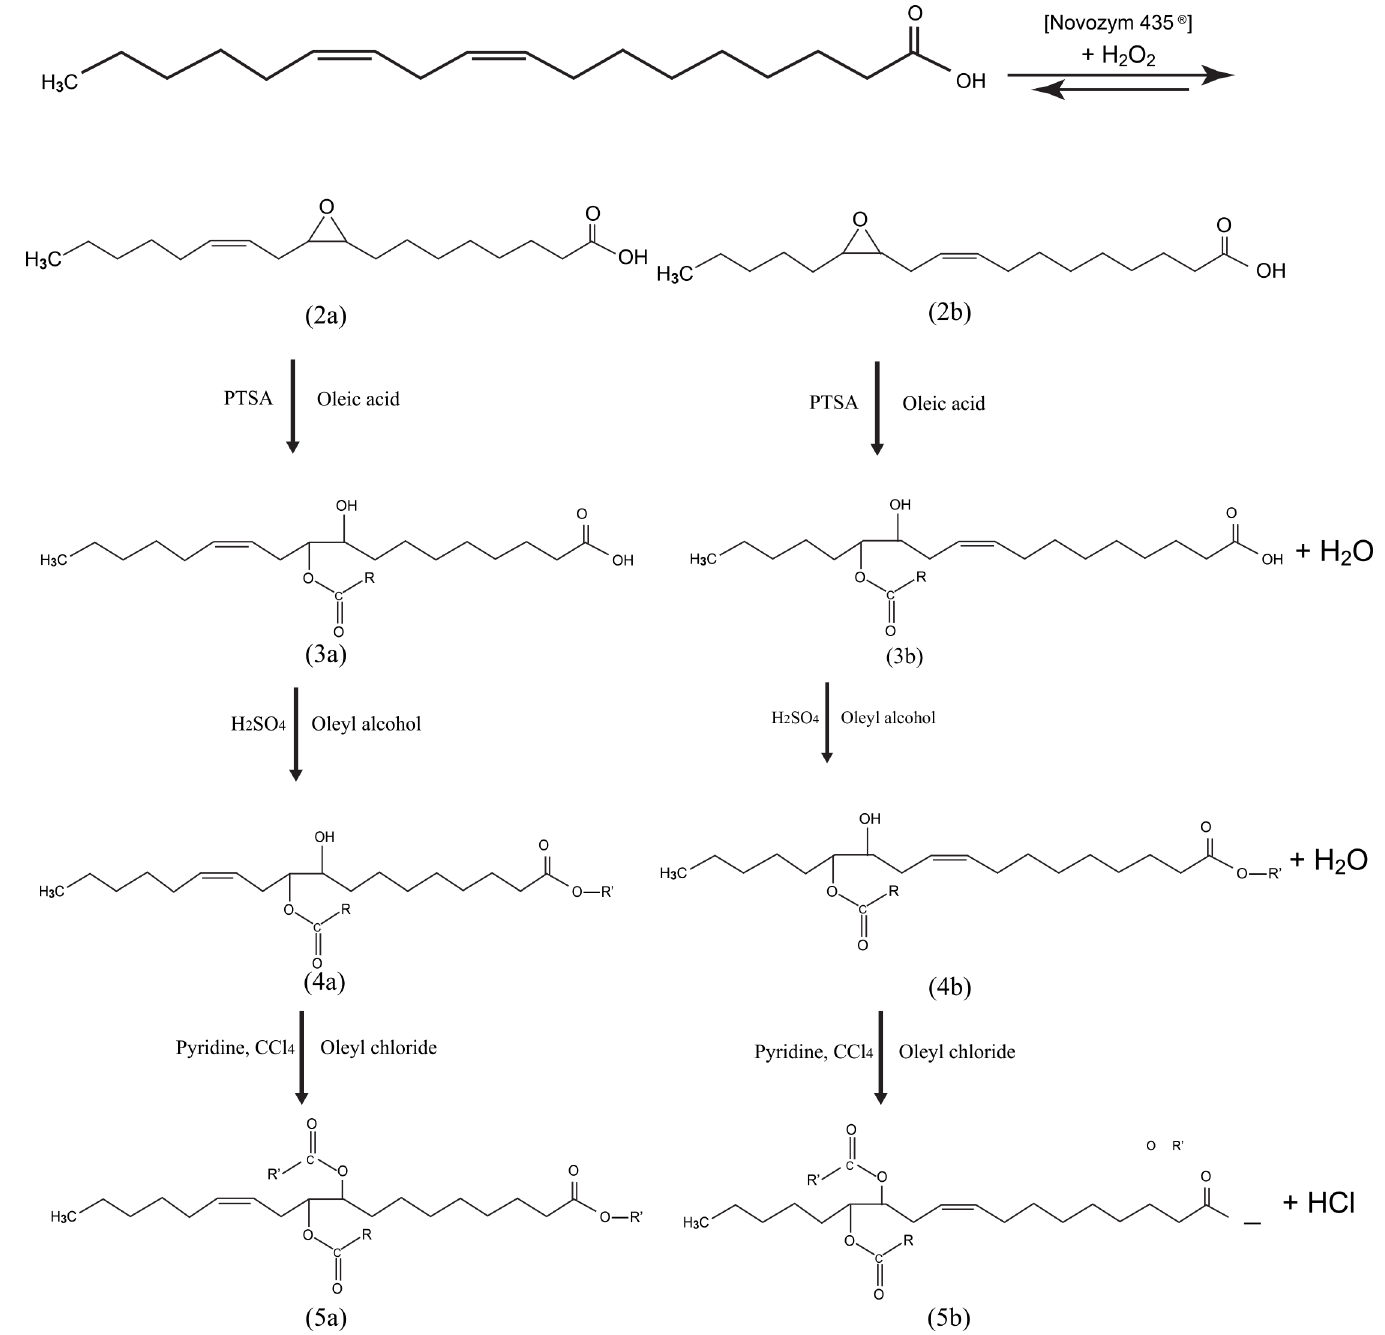
Fig 1. Reaction scheme for the formation of triester. (2a, 2b) cis-9, 10-epoxy 12c- 18:1 and cis-12, 13 epoxy 9c- 18:1. (3a, 3b) 9,(12)-hydroxy-10,(13)- oleioxyoctadecanoic acid. (4a, 4b) oleyl 9,(12)-hydroxy-10,(13)-oleioxyoctadecanoate. (5a, 5b) oleyl 9,(12)-oleoyloxy-10,(13)-oleioxyoctadecanoate.